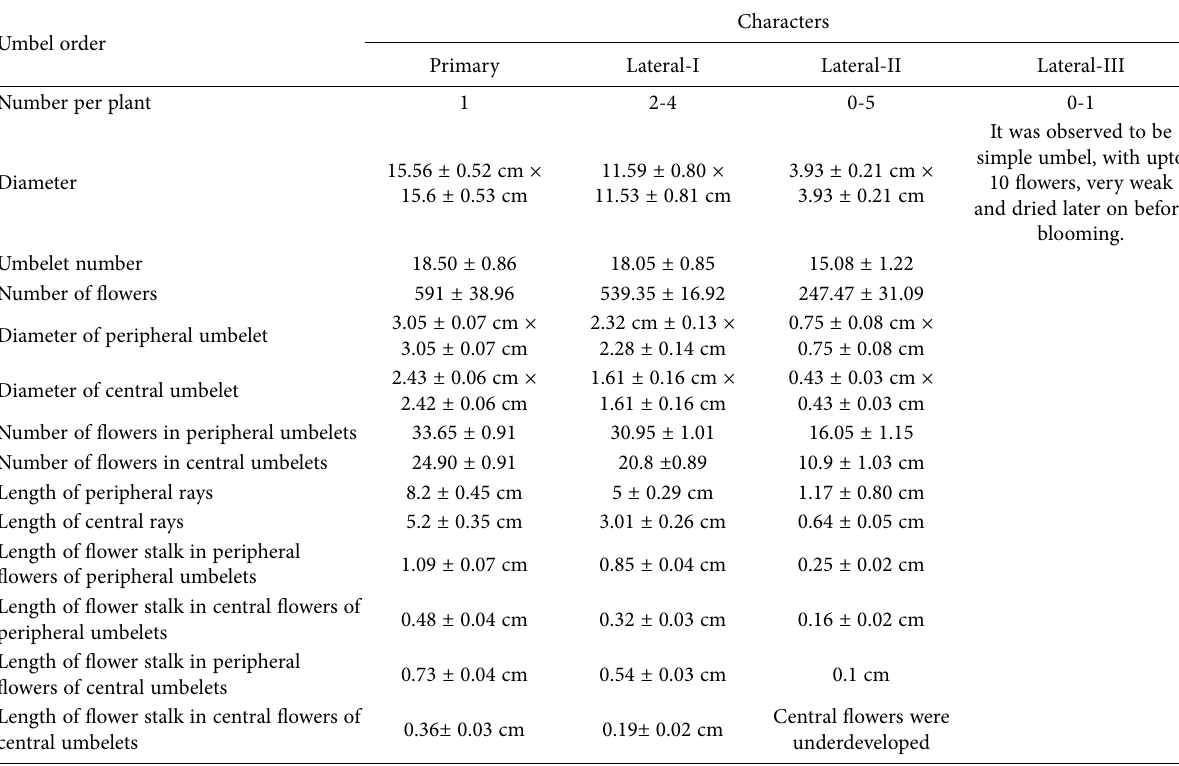
Table 3. Quantitative features of umbels of different order in A. glauca :